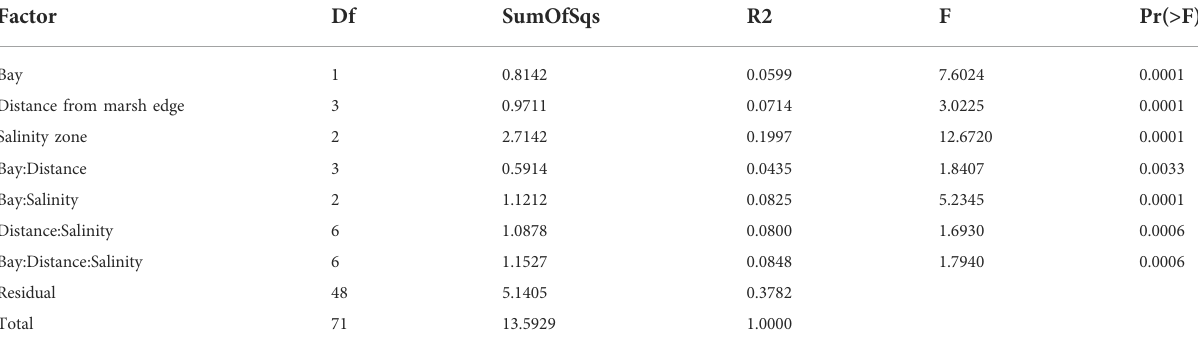
TABLE 1 Adonis test results for differentiation of metazoan communities among samples from different bays (Caillou and Barataria), distances from the marsh edge (0, 1, 5, and 10 m) and salinity zones (low, mid, and high). All p -values remained signi fi cant after the Benjamini-Hochberg